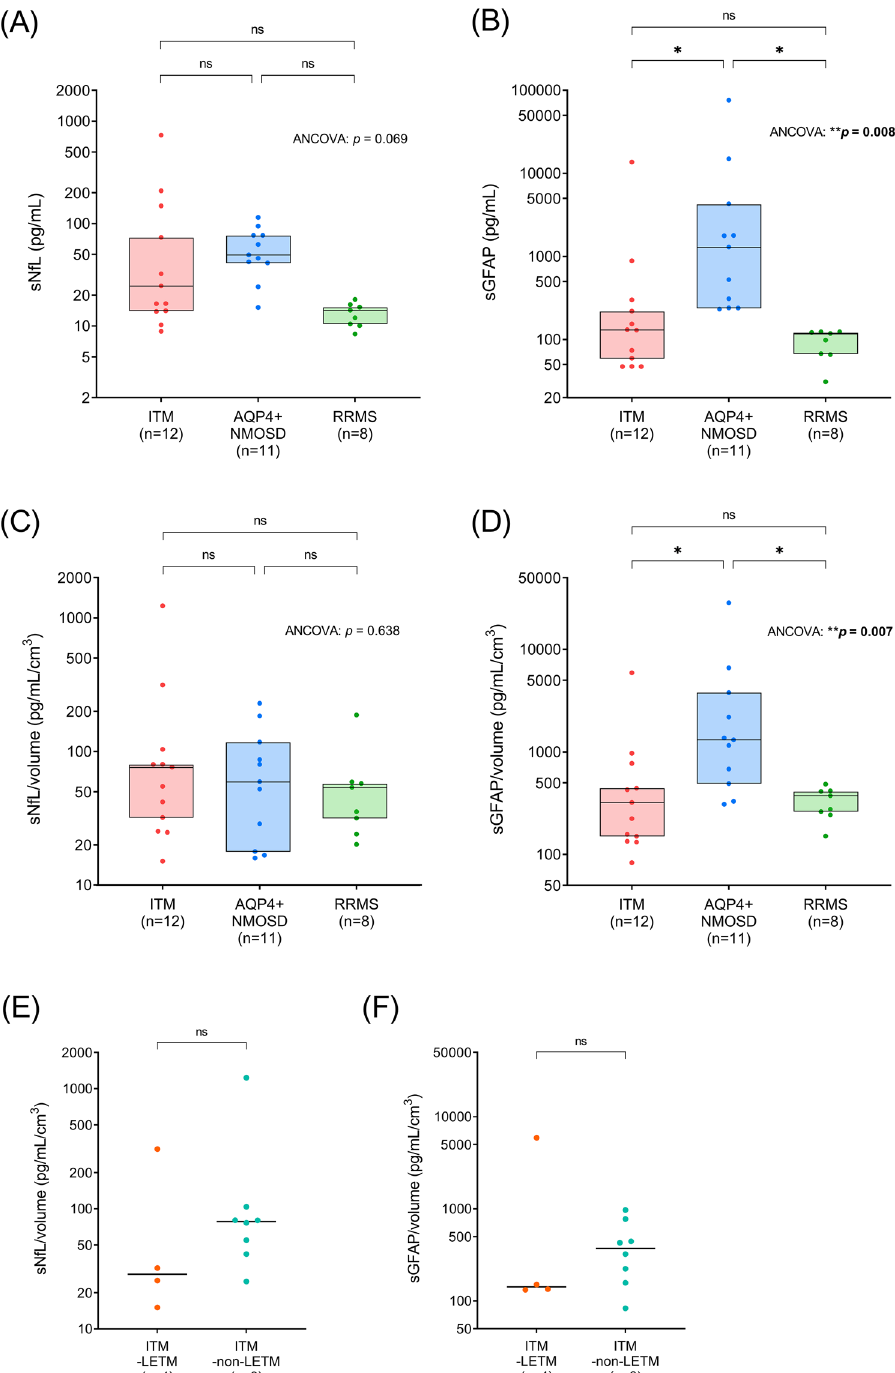
Figure 4. Comparison of serum biomarkers between ITM and other CNS inflammatory demyelinating diseases during acute transverse myelitis attacks. All patients experienced an acute transverse myelitis attack within the last two months before blood sampling. ( A , B ) sNfL and sGFAP levels were compared between patients with ITM (n = 12), those with AQP4 + NMOSD (n = 11) and those with RRMS (n = 8). ( C , D ) T2 lesion volume- divided sNfL and sGFAP levels were compared between patients with ITM and those with other diseases. The boxes represent medians and interquartile ranges (IQR). ( E , F ) T2 lesion volume-divided sNfL and sGFAP were compared between ITM patients with LETM and those without LETM. Bars represent medians. Age was regarded as a covariate in the analyses. p values with statistical significance (* p < 0.05 and ** p < 0.01) are presented in bold. sNfL: serum neurofilament; sGFAP: serum glial fibrillary acidic protein; ITM: idiopathic transverse myelitis; AQP4 + NMOSD: aquaporin-4 antibody-positive neuromyelitis optica spectrum disorder; RRMS: relapsing–remitting multiple sclerosis; LETM: longitudinally extended transverse myelitis; ANCOVA: analysis of